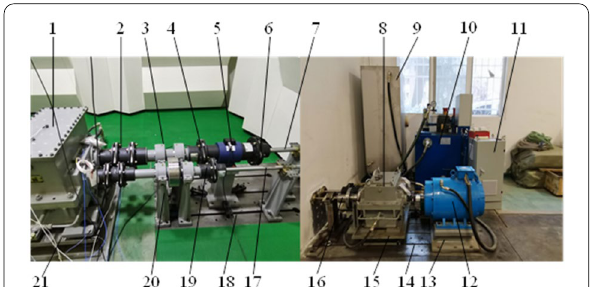
Figure 15 The mechanical power flow closed test bench. 1. Test